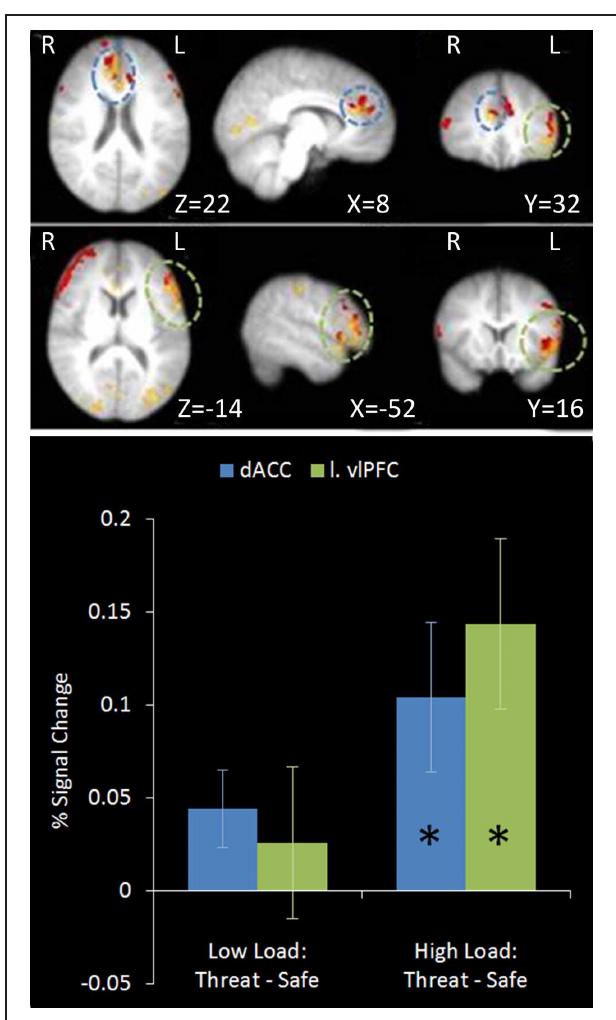
FIGURE 9 | Top: Top-down control regression imaging results overlaid on main effect top-down control (red). This identified regions where activation under the top-down control contrast in the emotional control task correlated with the index of attentional control from the dichotic listening task. Medial (upper panel) and lateral (lower panel) views are displayed. Dorsal ACC and left vlPFC identified by this analysis displayed some overlap with the main effect top-down control results. Bottom: Pairwise comparisons of the signal change in the regions identified. Both regions displayed a significant increase in activation under threat compared to safety in High Load conditions [Cingulate: High Load/Threat—High Load/Safe: mean difference = 0.104%, S . D = 0 . 170, t ( 17 ) = 2 . 585, p = 0 . 019; left vlPFC: High Load/Threat—High Load/Safe: mean difference = 0.143%, S . D = 0 . 194, t ( 17 ) = 3 . 133, p = 0 . 006]. The cingulate also displayed a borderline significant increase under threat in Low Load conditions [mean difference = 0.044%, S . D = 0 . 089, t ( 17 ) = 2 . 094, p = 0 . 052]. Error bars display within-subject standard error (Morey, 2008). ∗ p < 0 . 05